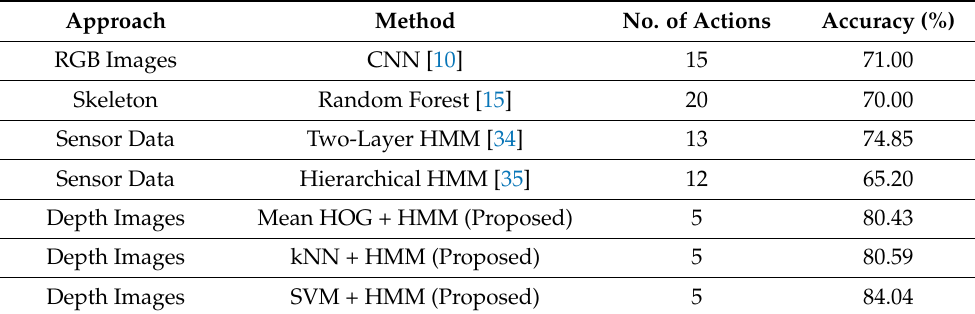
Table 8. Comparison of recognition accuracy between the proposed methods and those in previous